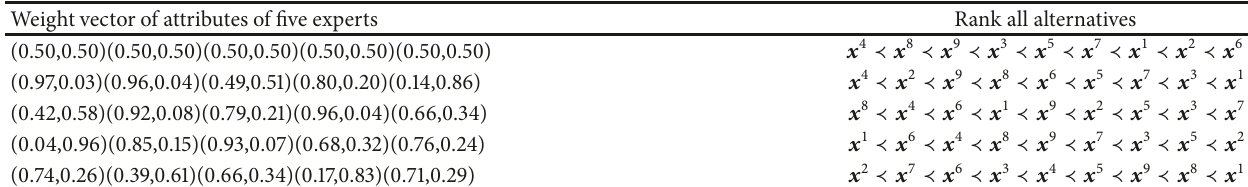
Table 3: Approach to MGDMP based on determining the weights of experts by using projection method [5]. Weight vector of attributes of five